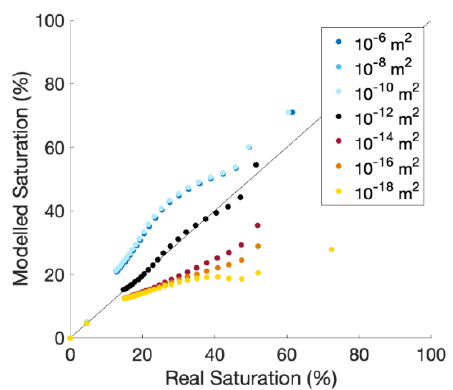
Figure 8. The effect on aFO-DTS accuracy due to permeability values changing in the region surrounding the fiber-optic cable relative to the saturation measured by the observation node with the default permeability conditions. These simulations test the effect of variability in soil permeability rather than the protocol’s ability to account for changes in permeability relative to the observation node’s